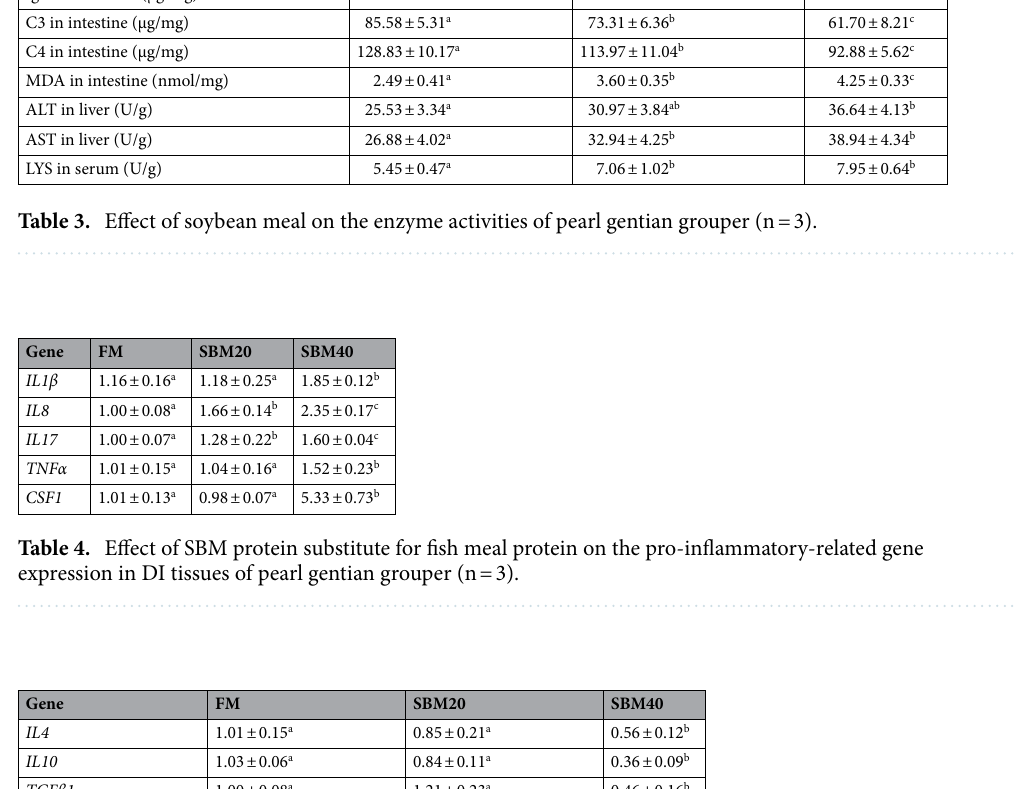
Table 5. Effect of SBM protein substitute for fish meal protein on the anti-inflammatory-related gene expression in DI tissues of pearl gentian grouper (n = 3).